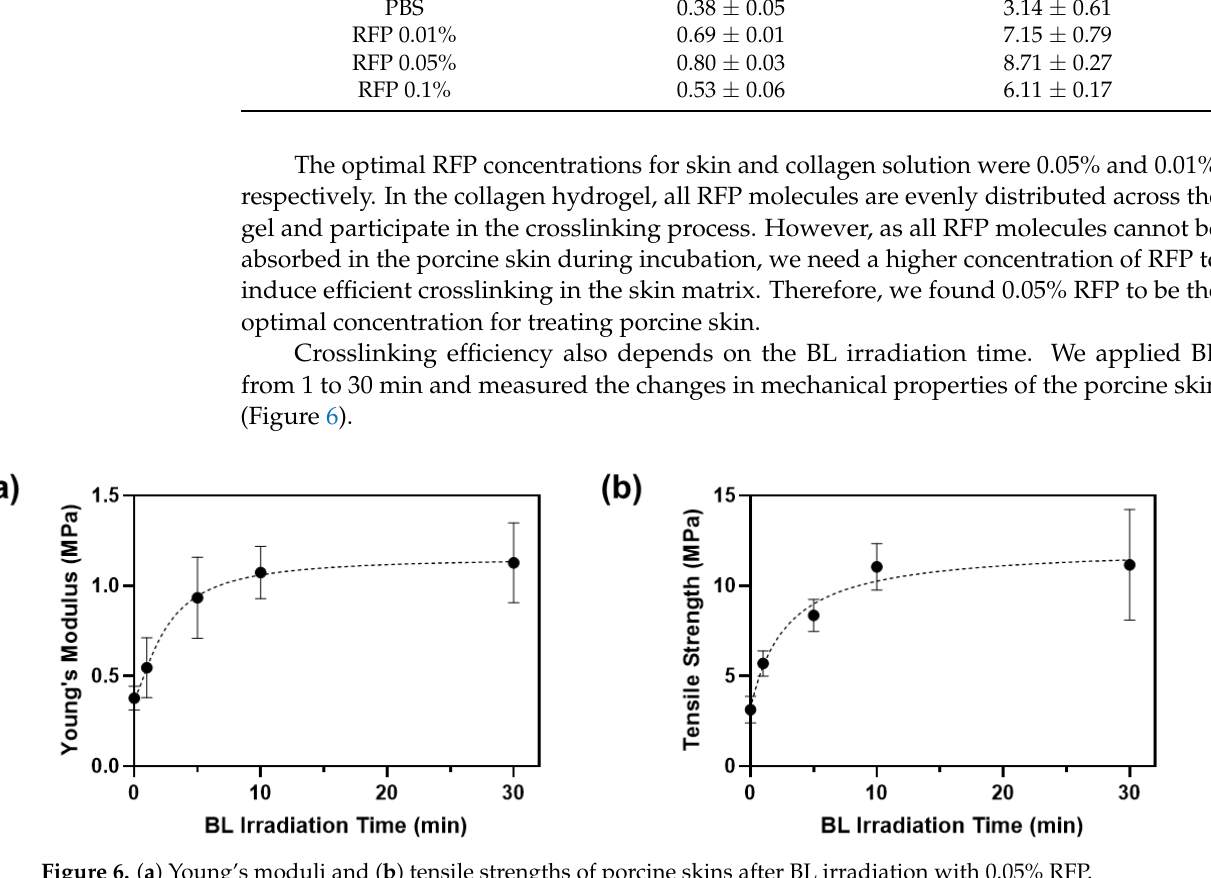
Table 2. Young’s moduli and tensile strengths of porcine skins by 5-min BL irradiation and different RFP concentrations. Group